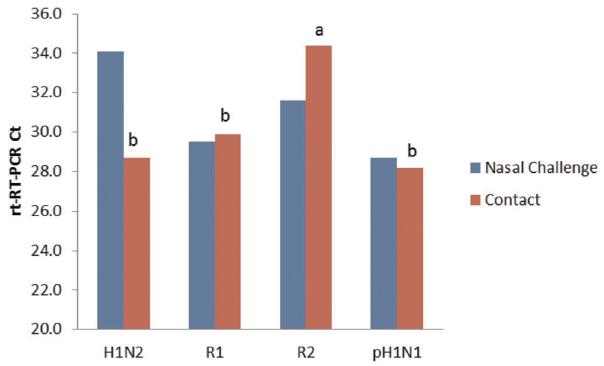
Figure 6. Lung samples were collected on day five post infection and analyzed for viral RNA by rt-RT-PCR. Data represent the mean Ct value for the four lung samples per treatment group. Samples with different subscripts within the same treatment group are statistically different (P , 0.05).